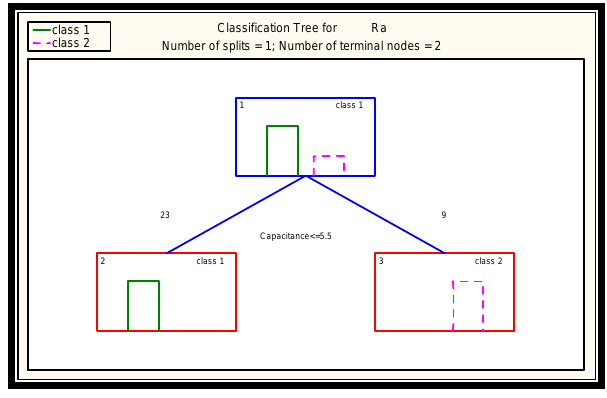
Fig. 1. Classification tree for Ra (two